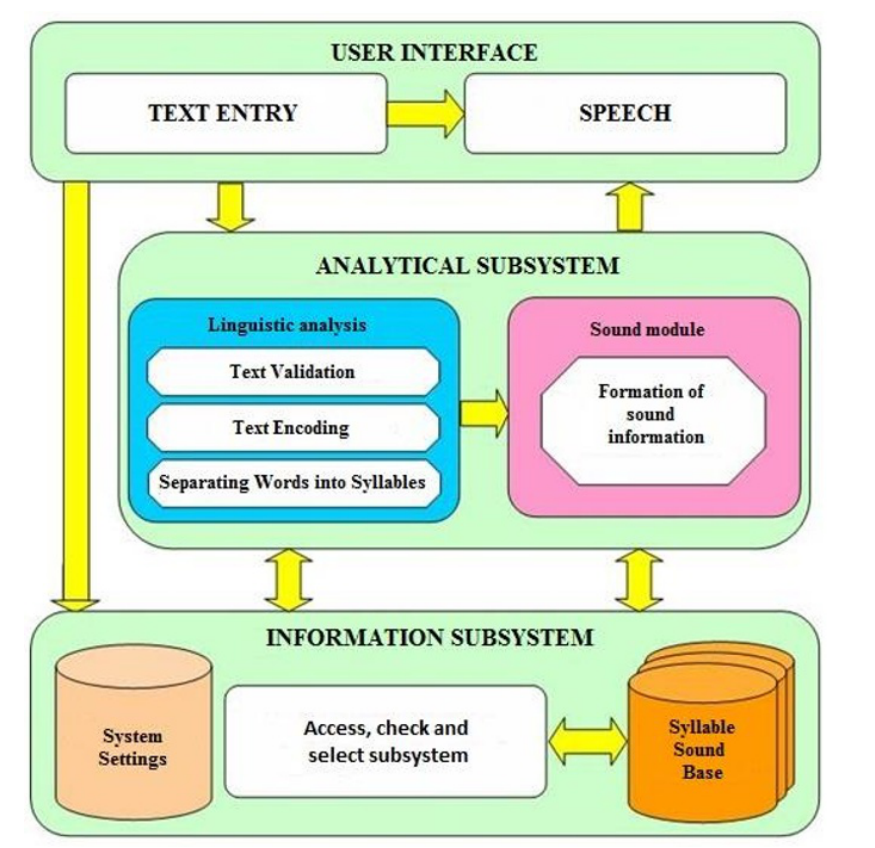
Fig. 2. Block diagram of Tajik